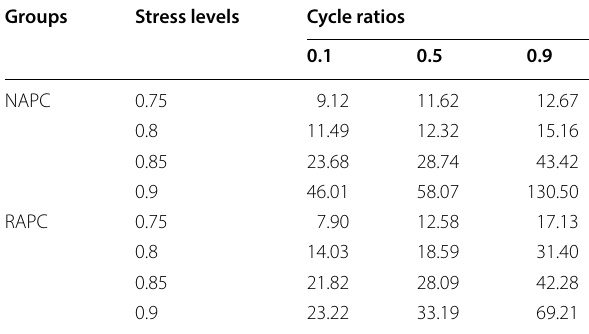
Table 4 Areas of hysteresis loop at different stress levels